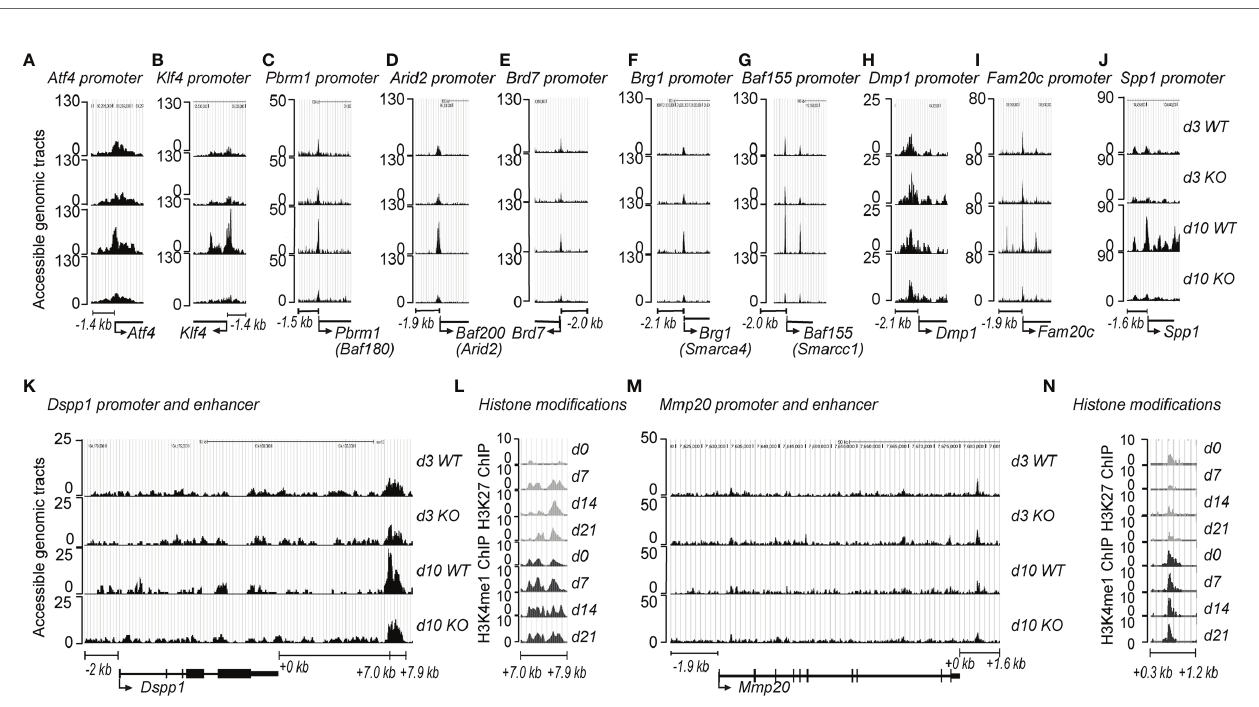
FIGURE 5 | BAF45A-PBAF complex regulates chromatin accessibility and bone-speci fi c gene transcriptional network. Baf45a fl oxed allele was deleted in primary calvarial osteoblasts via 4-hydroxytamoxifen inducible CAG -Cre genetic background. The cells were then subjected to osteogenic differentiation. Osteoblasts were harvested at day 3 and day 10 of differentiation. ATAC-seq was performed on WT and Baf45a knockout osteoblasts. (A, B) Chromatin accessibility at the gene loci of transcriptional factors Atf4 and Klf4 , (C – G) Genomic accessibility pro fi les of PBAF subunits, and tooth and bone-related genes (H) Dmp1 , (I) Fam20c , (J) Spp1 , (K) Dspp1 , and Mmp20 (M) . ChIP-sequencing analysis was performed in BMSCs using the anti-H3K27ac and anti-H3K4me1 antibodies to identify downstream enhancer regions of bone and tooth-related genes (L) Dspp1 , (N) Mmp20 . “ Y-axis ” indicates accessible genomic tracts, and the “ X ” axis denotes the genomic